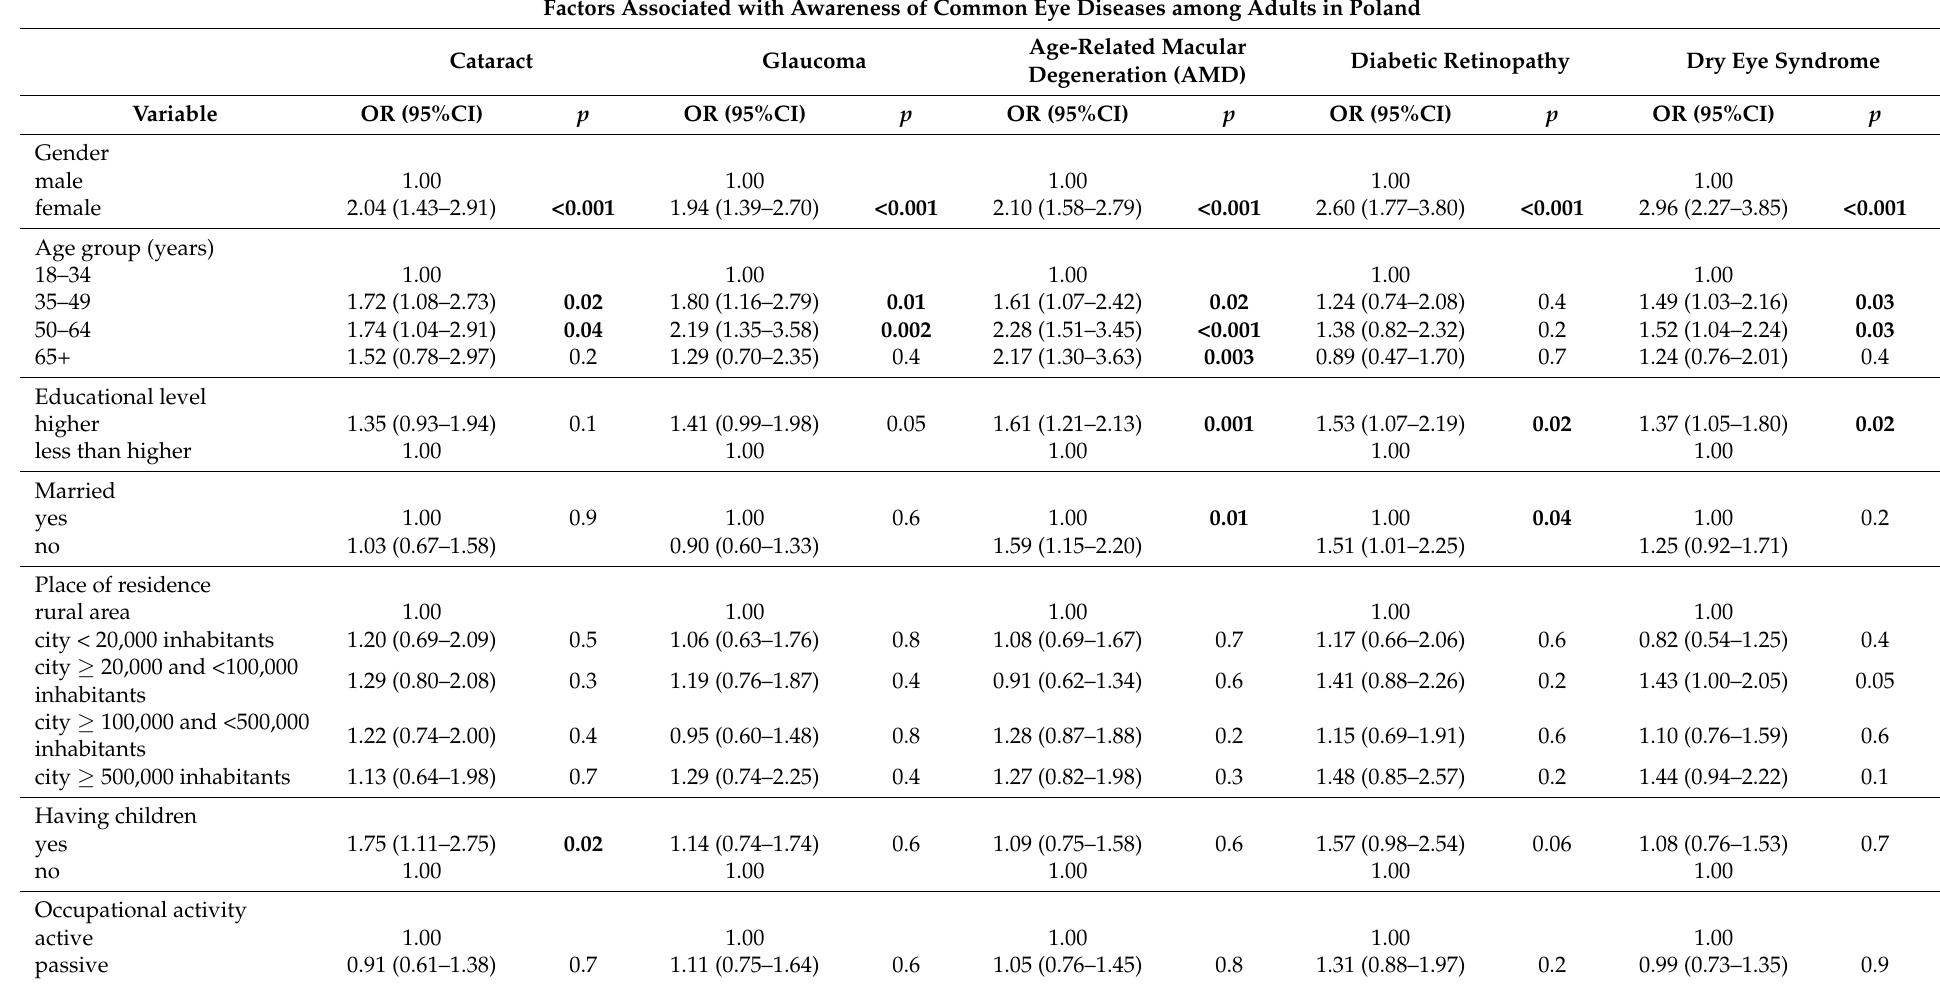
Table 6. Factors associated with awareness of common eye diseases among adults in Poland (n = 1076). Factors Associated with Awareness of Common Eye Diseases among Adults in